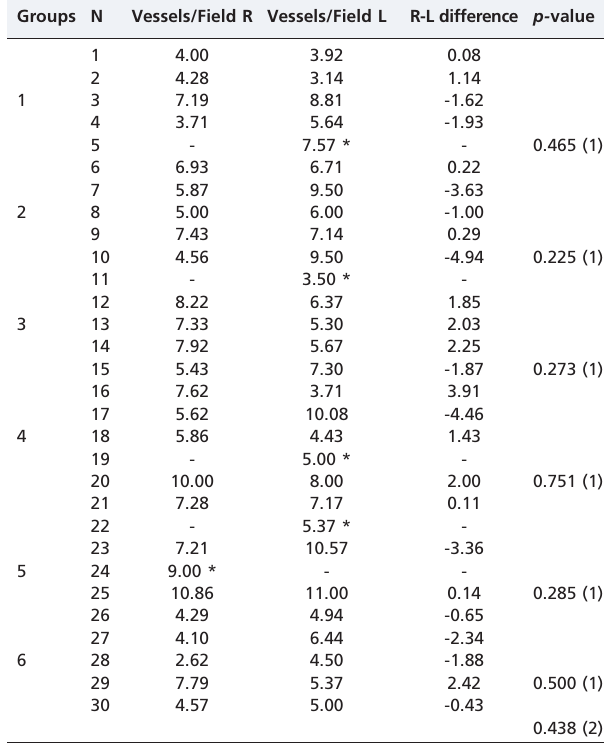
Table 2 - Blood vessels per field from HEST-treated (left) and untreated (right) patellar tendons, indicating the differences between them.